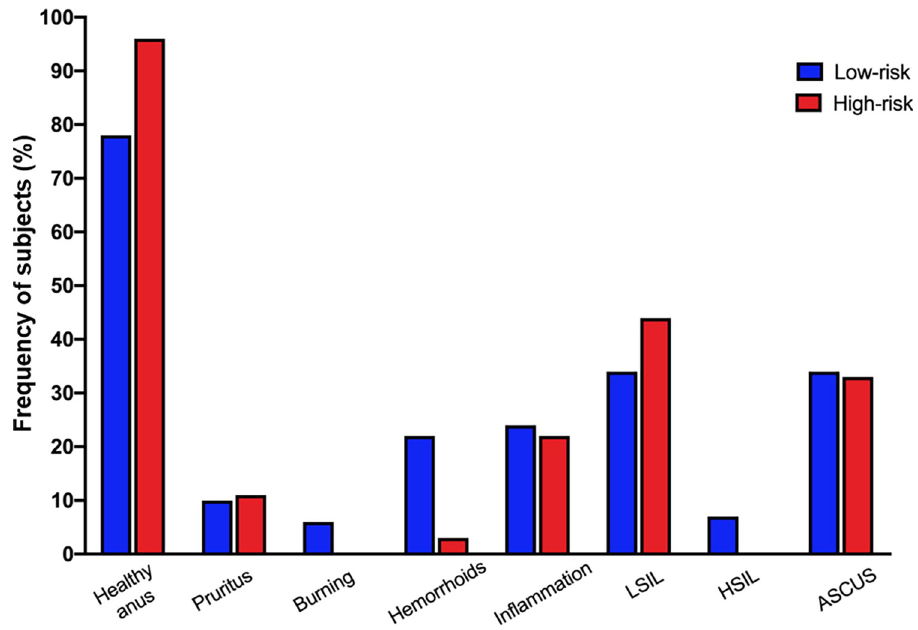
Fig 4. Symptoms, macroscopic, and microscopic findings in anal mucosa tissue of both MSM groups. Comparison of symptoms, macroscopic, and microscopic findings in the anal mucosa tissue of both MSM groups. Data represent the percentages of people presenting each condition. No statistical differences were found between both groups through the Chi-square test. Low-risk (n = 29), high-risk (n = 9). ASCUS: atypical squamous cells of uncertain significance; LISIL: low-grade squamous intraepithelial lesion; HSIL: high-grade squamous intraepithelial lesion.